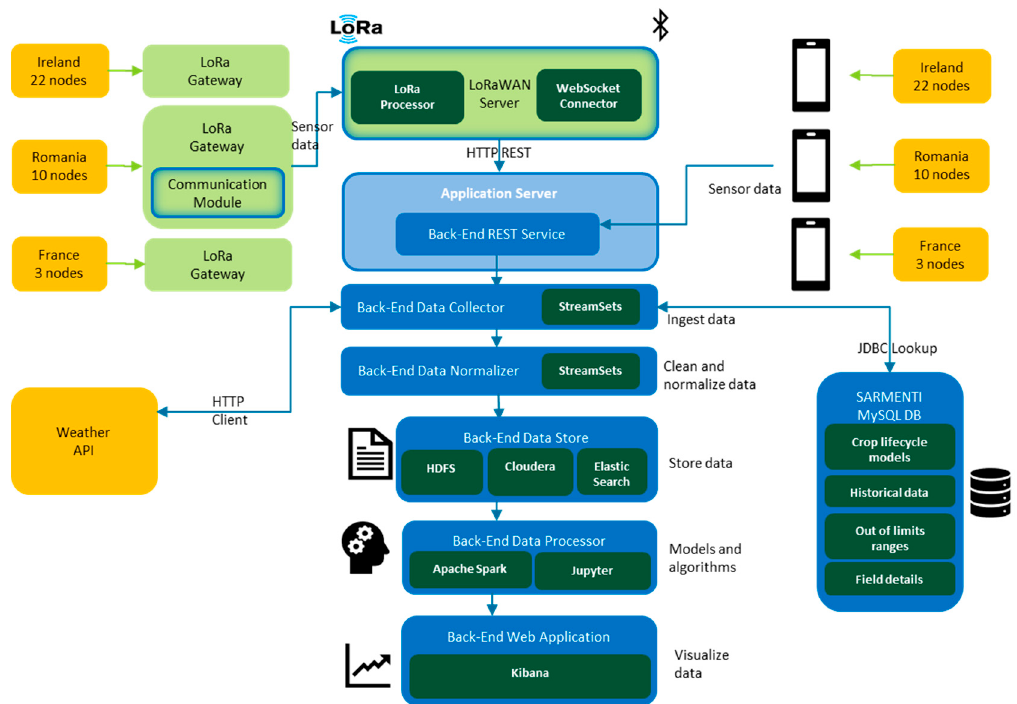
Figure 18. Analytics platform and communication paths from IoT devices.